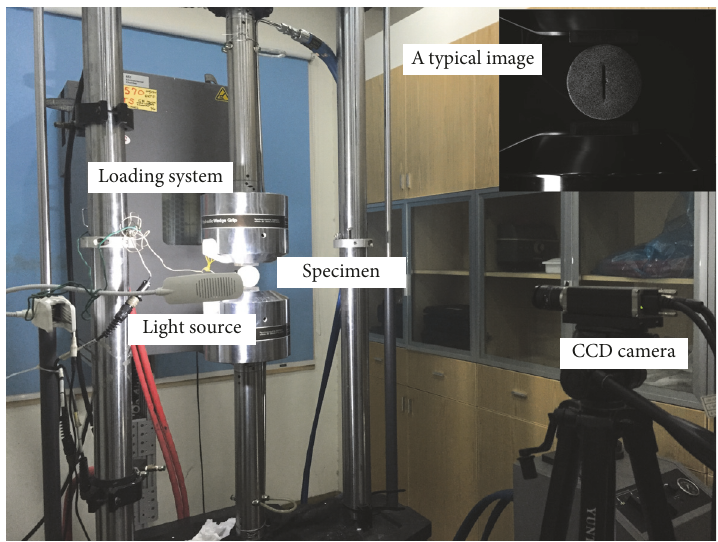
Figure 3: Test equipment of the DIC system.